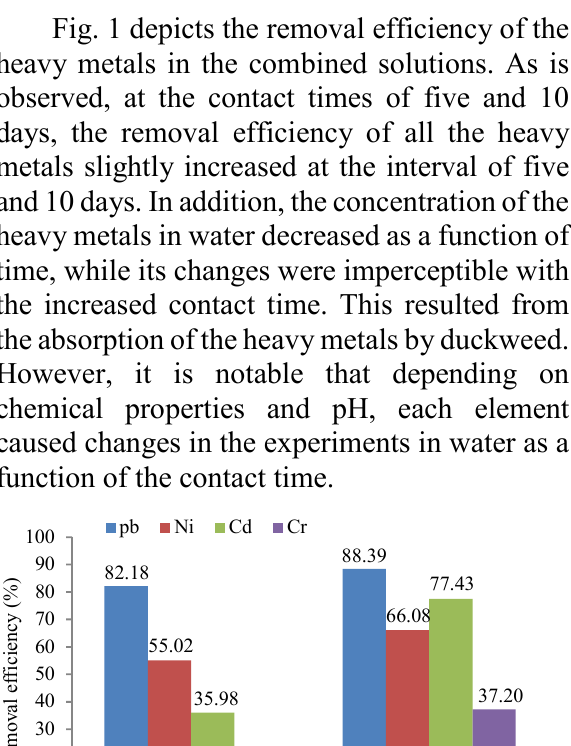
Fig. 1. Duckweed efficiency in combined heavy metal removal at concentration of 5 mg/l (duckweed weight: 0.2 g)